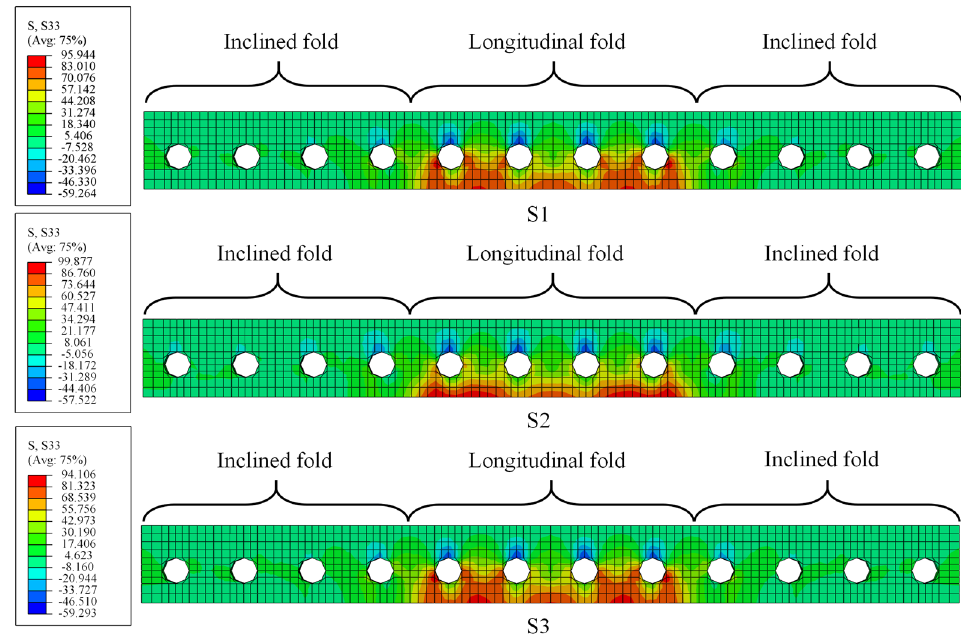
Figure 17. Stress status of the PBL under transverse bending moments.